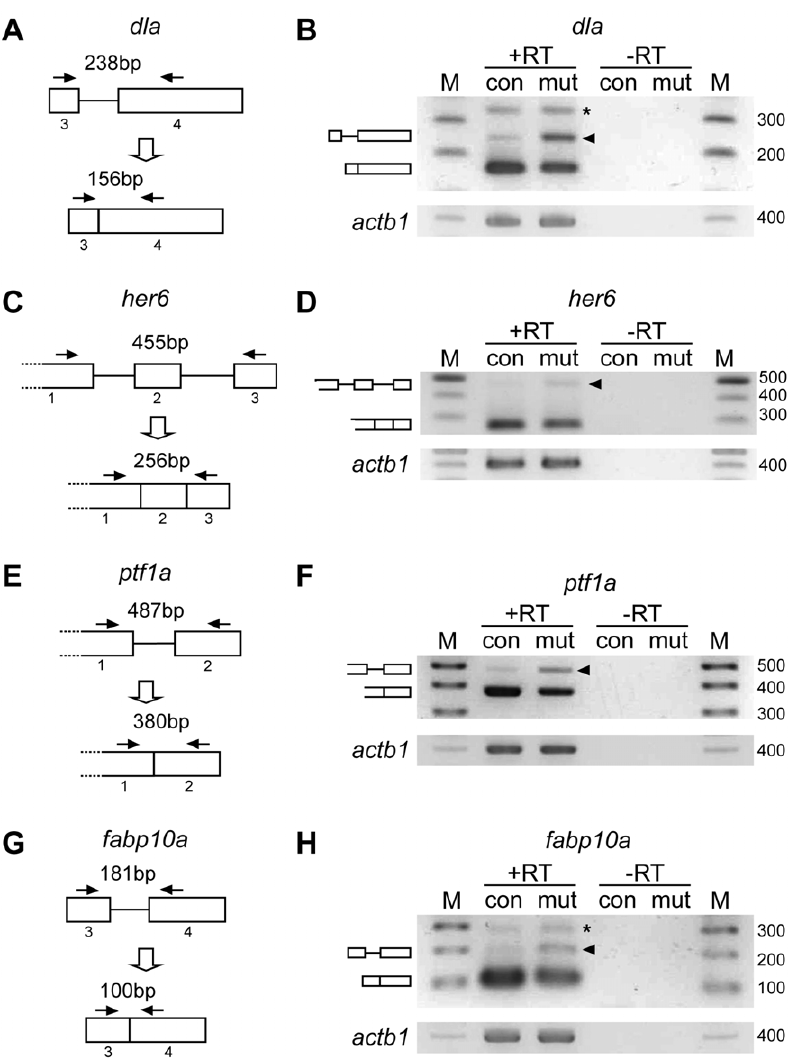
Figure 6. Ddx46 deficiency affects pre-mRNA splicing in the digestive organs and brain. (A–H) Scheme of the dla , her6 , ptf1a , and fabp10a pre-mRNA regions analyzed for splicing (boxes, exons; lines, introns; arrows, primers) (A, C, E, G). The splicing status of dla , her6 , ptf1a , and fabp10a pre-mRNA was monitored using RT-PCR with the primers indicated in scheme A, C, E, and G, respectively. Unspliced dla , her6 , ptf1a , and fabp10a mRNAs were retained in the Ddx46 hi2137/hi2137 mutant (mut) larvae compared to the control (con) larvae (arrowheads in B, D, F, H). Unspliced and spliced PCR products were verified by sequencing. + RT refers to the validation reaction itself, and 2 RT represents the respective control reaction without reverse transcriptase. actb1 is a loading control by using primers designed in the exon 6. M, DNA size markers (sizes in bp); the asterisks point to nonspecific PCR products. Control larvae were sibling WT or Ddx46 hi2137/ + larvae and had normal phenotypes.